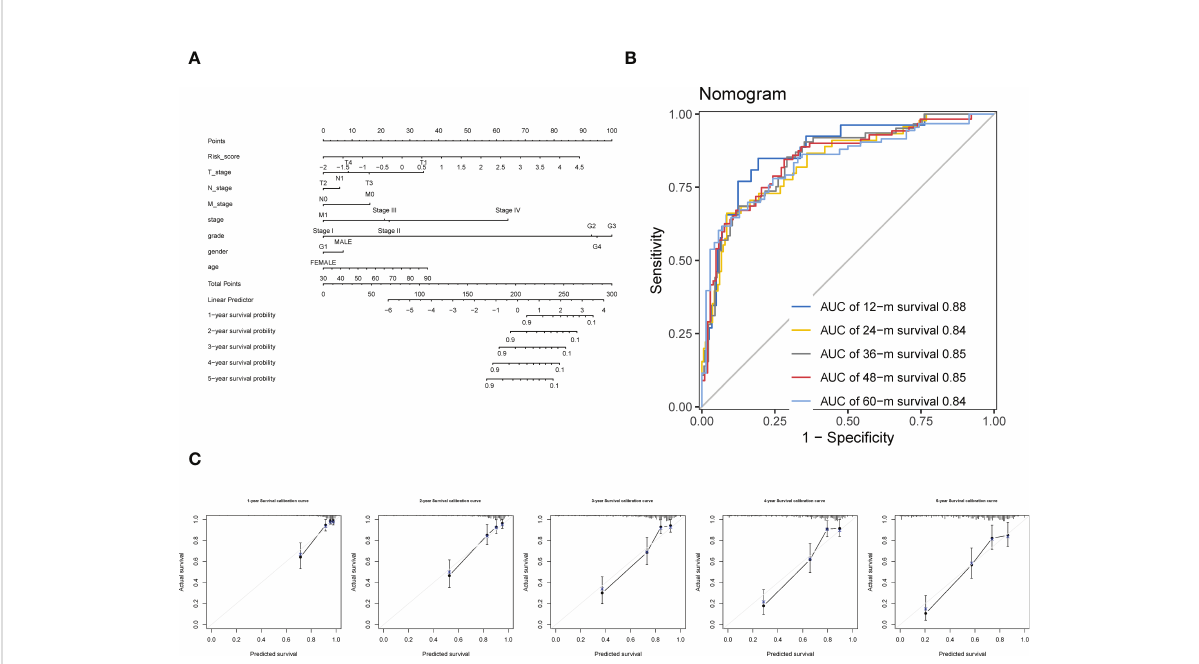
FIGURE 10 Construction of a Nomogram using integration CTR score and clinicopathologic variables. (A) claudin-TME related (CTR) score integrated with T (tumor stage), N (node stage), M (metastasis stage), neoplasm histologic grade, neoplasm disease stage, sex, and age to develop a Nomogram in ccRCC. (B) Time-dependent receiver operating characteristic (ROC) curves of the Nomogram. (C) Calibration curve for the prediction of overall survival (OS) at 1 – 5